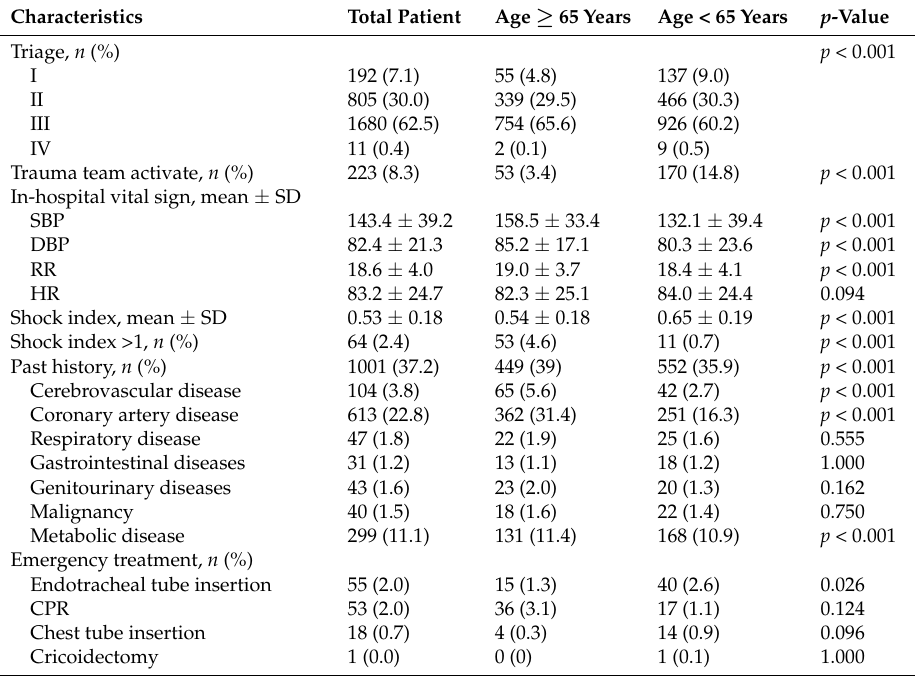
Table 2. In-hospital clinical parameters of younger and elderly patients.